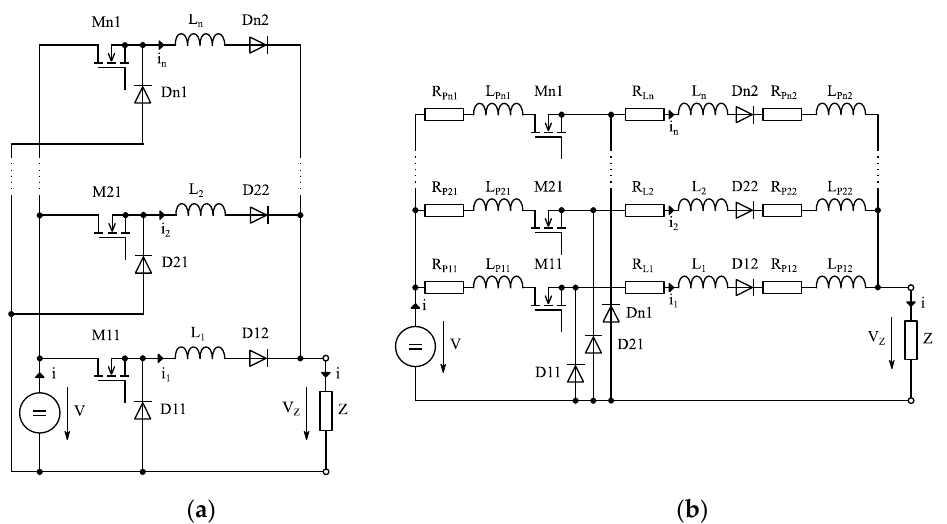
Figure 1. Schematic connection of n legs number of DC-DC converter ( a ) basic scheme ( b ) scheme with parasitic electrical components.